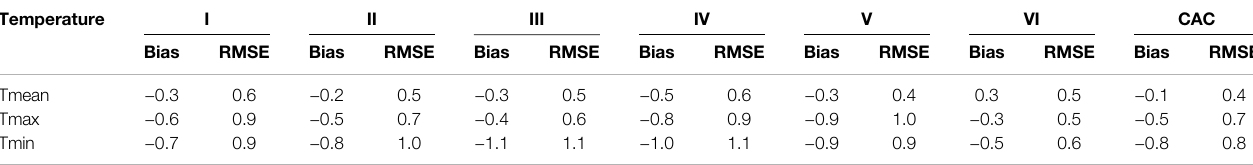
TABLE 1 | The Bias and RMSE between the projected and observed multi-year average Tmean, Tmin, and Tmax over CAC during 1996 – 2018 (Unit: °